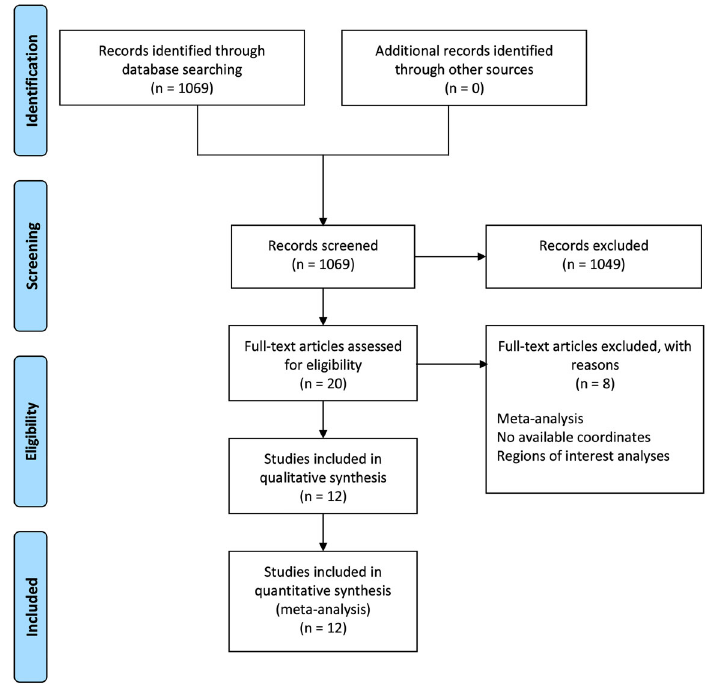
Figure 1. Search strategy used for the inclusion of studies that were considered for the meta-analysis.